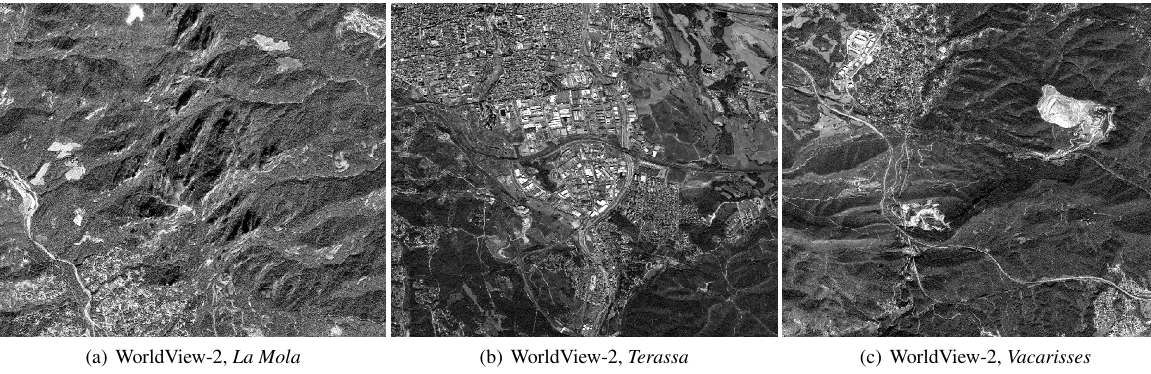
Figure 5: ISPRS dataset: Exemplary WorldView-2 images of the three sub datasets